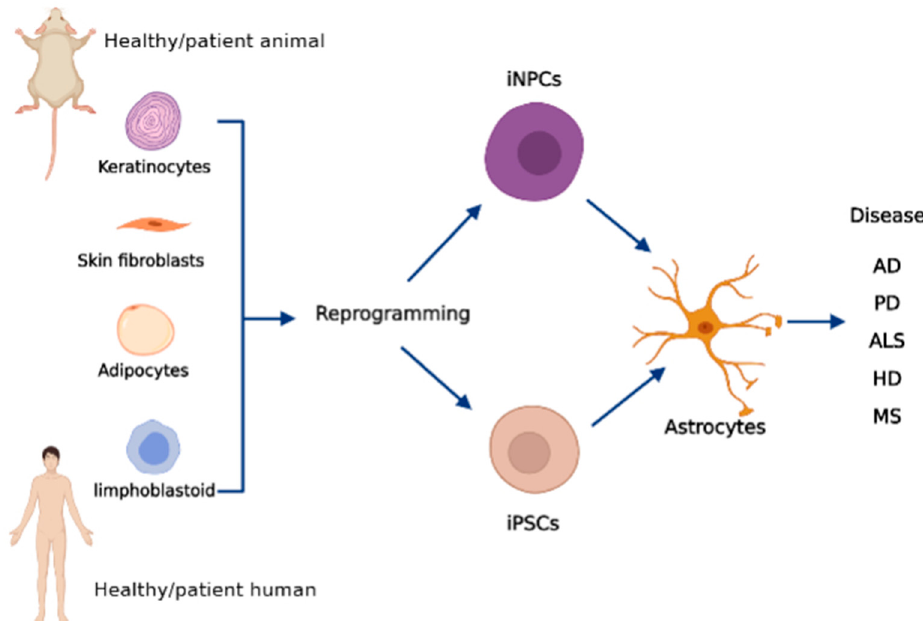
Figure 2. Schematic representation of the preparation of induced pluripotent stem cells (iPSCs) and induced neural progenitor cells (iNPCs) from human and rodent somatic cells and their transformation into astrocytes relevant to various neurodegenerative disorders.